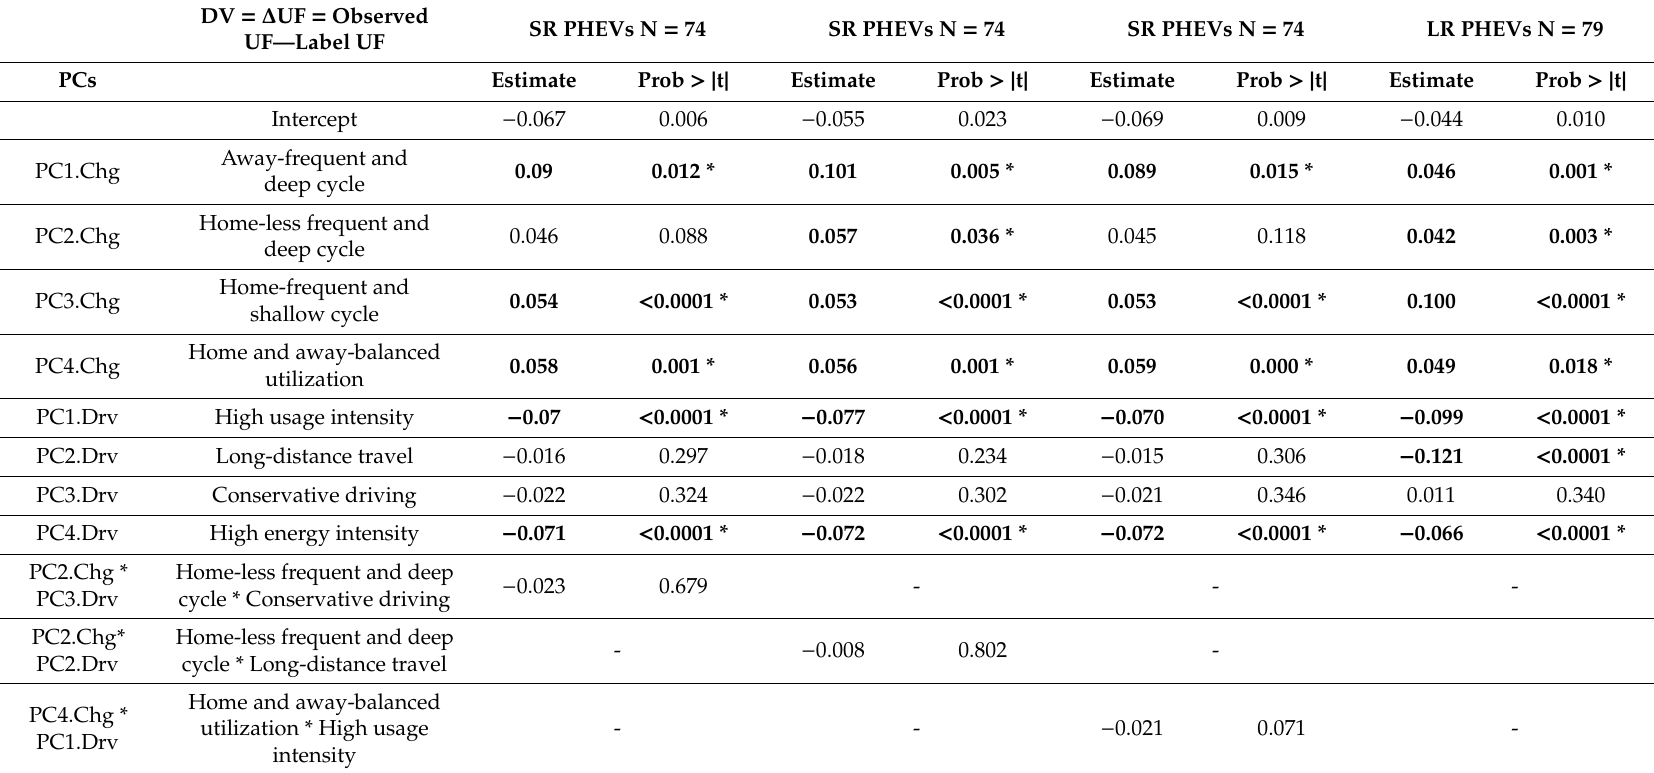
Table A3. OLS Regression Model Results with Interaction E ff